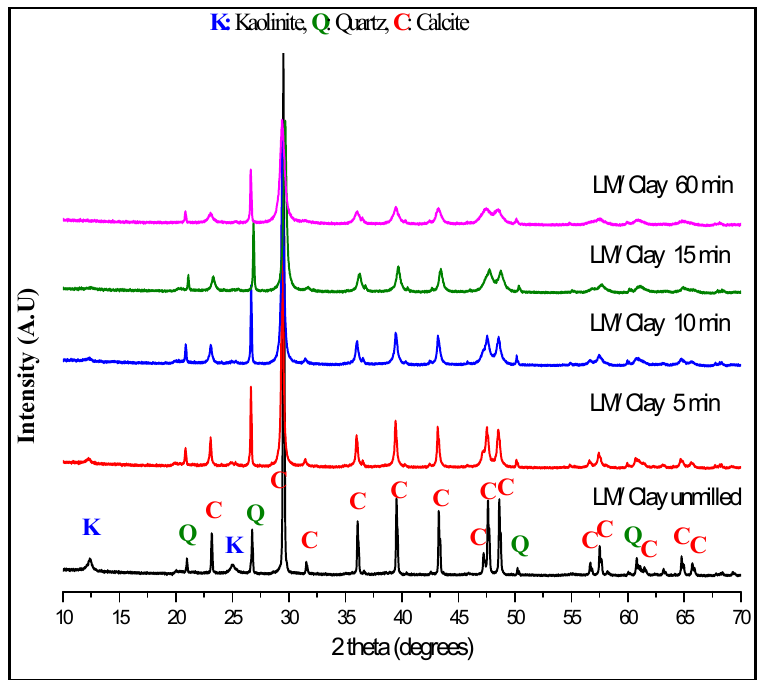
Figure 5. Diffraction patterns of a raw and milled mixture of limestone/clay for different